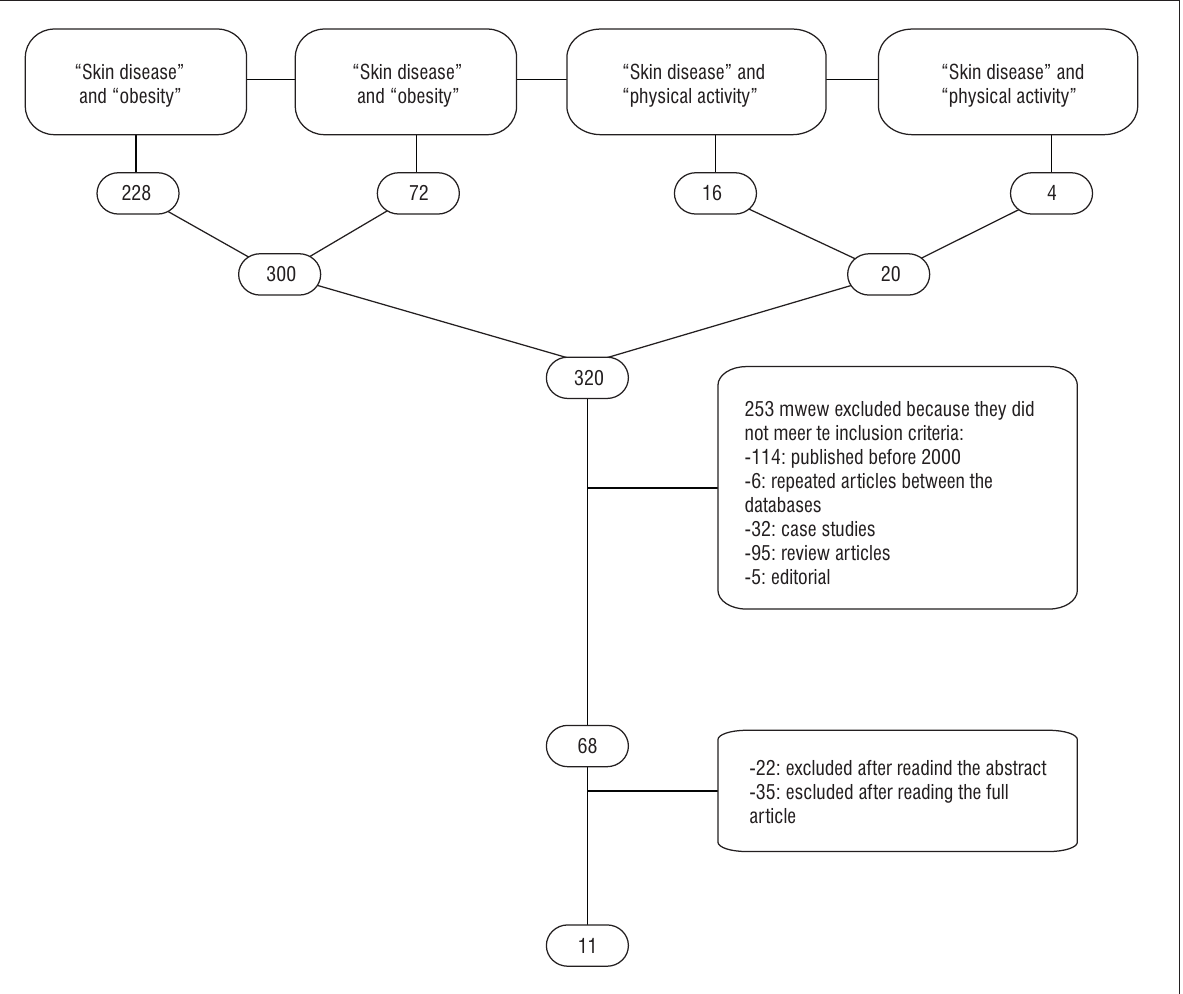
Figure 1 - Selection process of the studies included in this systematic The PEDro Scale was used to rate the methodological quality of the studies (Table 1)